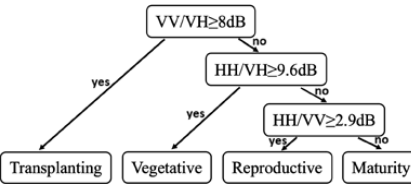
Figure 8. A decision tree classifier. Thresholds of VV/VH, HH/VV, and HH/VH divide SAR data into four phenological phases.